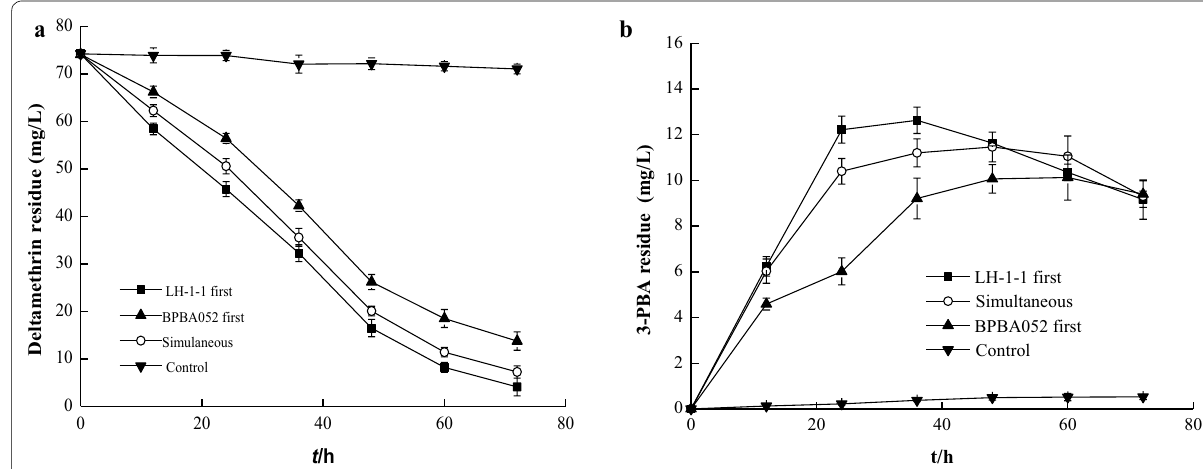
Fig. 3 Effect of inoculation sequences of strains A. junii LH-1-1 and K. pneumoniae BPBA052 on degradation of deltamethrin a and its metabolite 3-PBA ( b